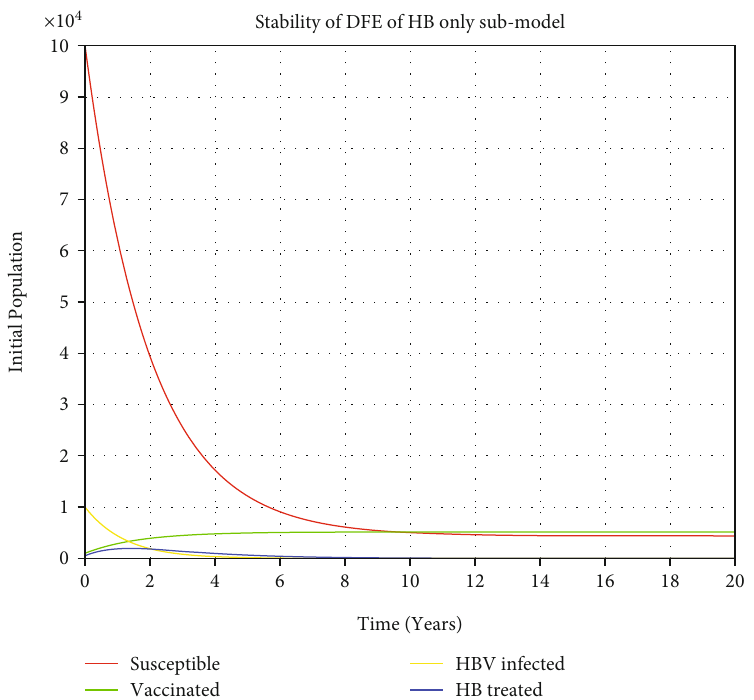
= 0 : 046 , ω = 0 : 09 , and μ = 0 : 5 . B eff